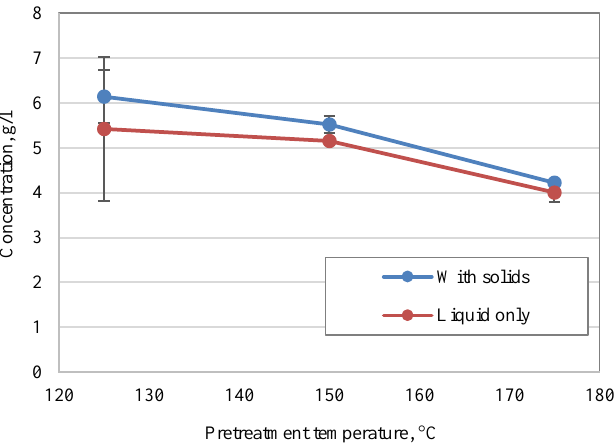
Fig. 3. Ethanol concentration after fermentation steps in case of different pretreatment temperatures using two fermentation approach – fermentation of liquids with solids and fermentation of liquids where solid fraction has been